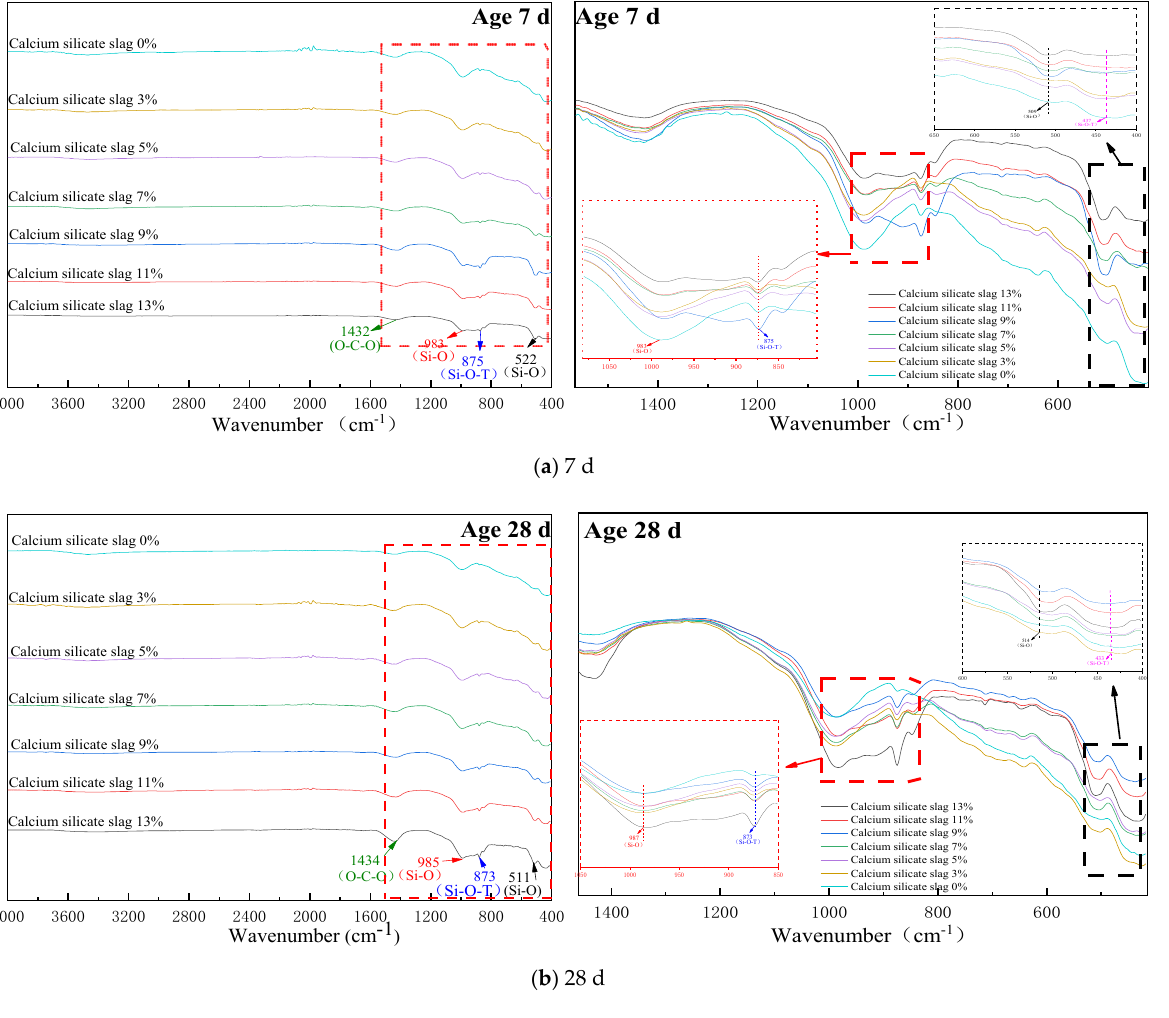
Figure 5. CSS base layer material FTIR diagram: ( a ) FTIR analysis of curing for 7 d, ( b ) FTIR analysis of curing for 28 d.